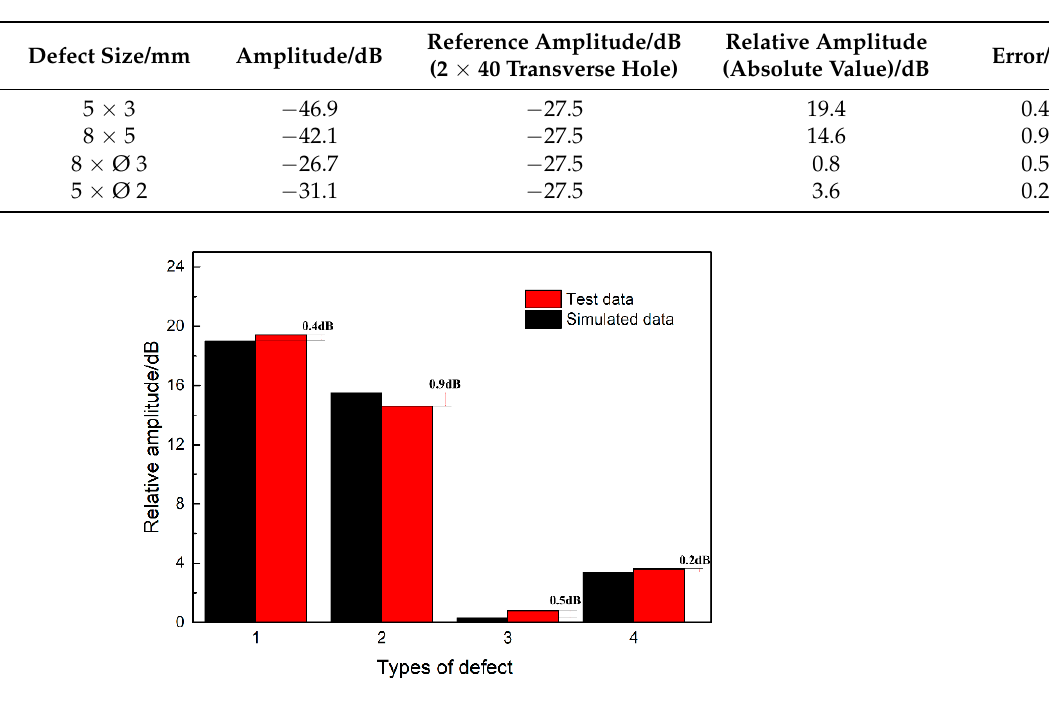
Table 3. Analysis of the test results of different types of defects.